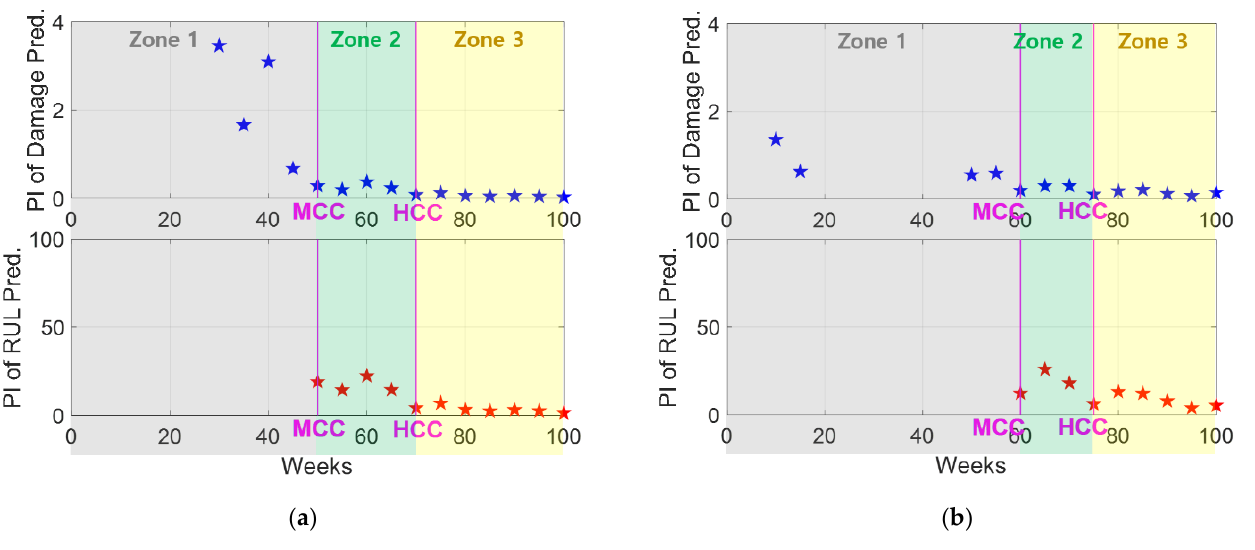
Figure 9. PIs and credibility criteria: battery degradation problem. ( a ) Small level of noise, ( b ) medium level of noise.